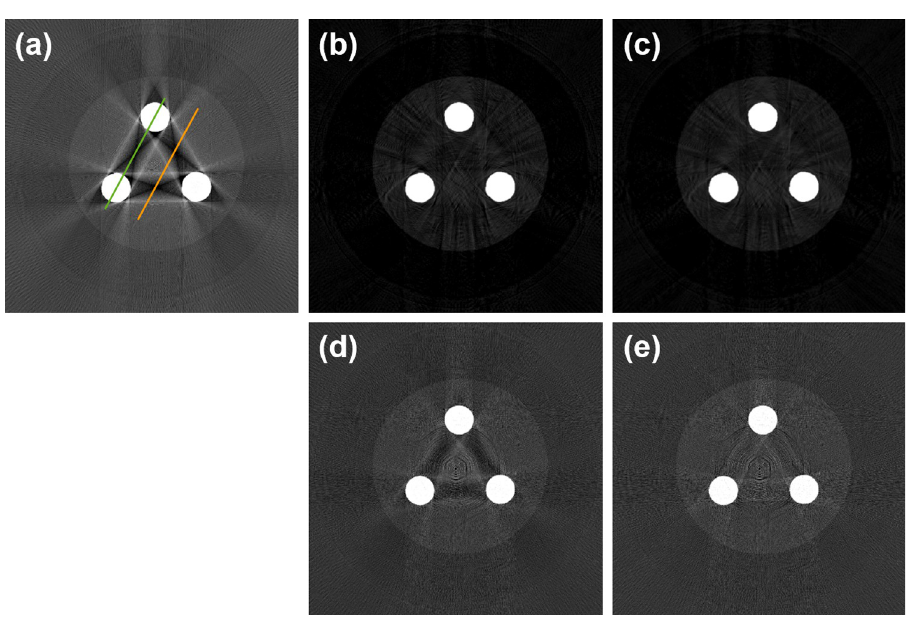
Fig 10. Experimental results using MAE phantom for evaluating the MAR methods. The green and orange lines denote different line-profile positions for the analysis. (a) The uncorrected CT image with 140 kV polychromatic X- ray. (b) The corrected CT images obtained using the LMAR method. (c) The corrected CT images obtained using the NMAR method. (d) The projection-based VMCT image obtained using a polynomial method (VMI-poly) at 100 keV. (e) The projection-based VMCT image obtained using the MLE and LUT method (VMI-Atable) at 100 keV. Window width and level of the image display are 11,000 HU and 4,500 HU, respectively. shows severe cupping artifacts (red arrows) and bright/dark streaks (purple arrows) induced by the high-density materials in the uncorrected CT image. Fig 11(B) and 11(C) show near perfect line profiles of the CT image corrected with the LMAR and NMAR methods, respec- tively. However, it is difficult to distinguish the object from the surrounding materials when the object is located in the position of the bright/dark streaks (purple arrows in Fig 11(B) and 11(C)) owing to the sinogram inpainting with the interpolating process of LMAR and NMAR (as indicated by the red arrows in Fig 9). Hence, the interpolating process of LMAR and NMAR leads to a smoothing effect of the corrected CT images and specific line profiles obtained in this study. Fig 11(D) and 11(E) also show that projection-based VMCT images can effectively eliminate cupping artifacts (red arrows) and bright/dark streaks (purple arrows). Moreover, the results of the projection-based VMI algorithm also yield the VMCT images and corresponding line profiles without the data smoothing processing. The experimental results of the line profiles indicated that the VMI-Atable algorithm performed better than the VMI- poly algorithm with respect to MAR in CT images. The object can be distinguished from the surrounding materials when the object is located in the position of the bright/dark streaks with the projection-based VMI algorithm (as indicated by the orange arrows in Fig 9). To assess the image distortion affected by the metal artifacts, the circularity of the Cu rod in the CT images obtained using the different MAR methods was calculated. The ROI for the cir- cularity calculation is shown in Fig 12(A). Fig 12(B)–12(F) show the CT images obtained using the various MAR methods. The Cu rod of the CT images obtained using the LMAR and NMAR methods revealed slight distortions (orange arrows), as shown in Fig 12(C) and 12(D), respectively. The image distortion was caused by the metal artifacts around the Cu rods. How- ever, the projection-based VMCT images indicated that the shapes of the Cu rods were not